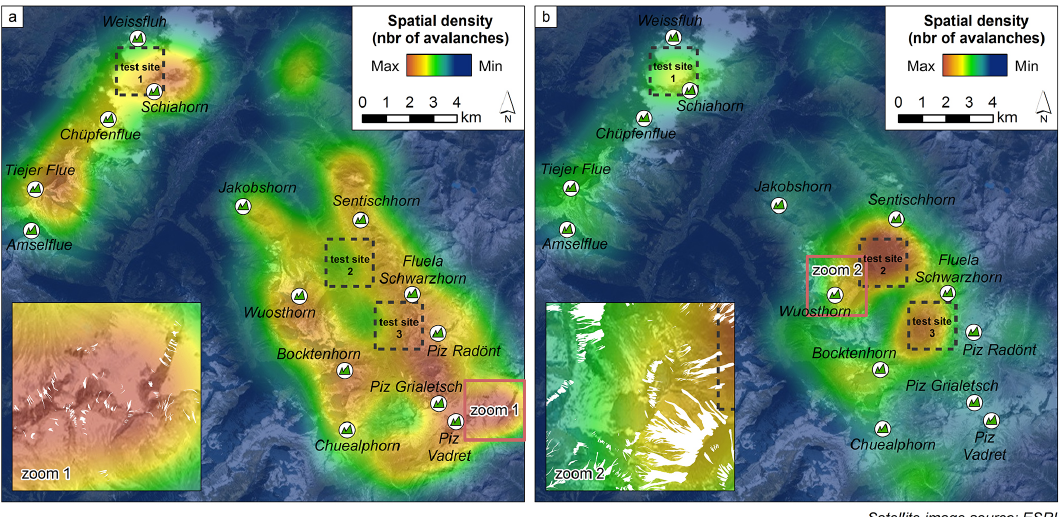
Figure 8. Density maps showing the clustering of avalanches in the winter of 2012–2013 with respect to their (a) quantity and (b) size. The insets (zoom 1 and zoom 2) show the density maps with respect to manually classified reference snow-avalanche polygons shown in white. Outlined test sites 1–3 are the test sites that were used for developing our OBIA